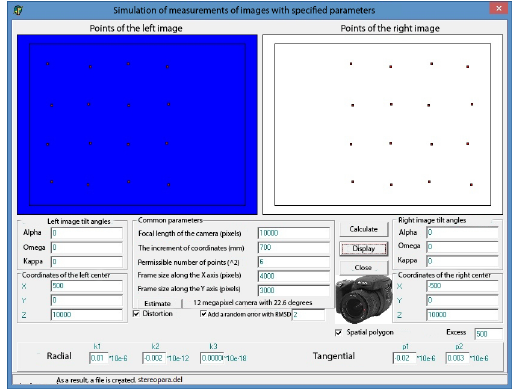
Figure 2. The menu window of the program for simulation of measurements of